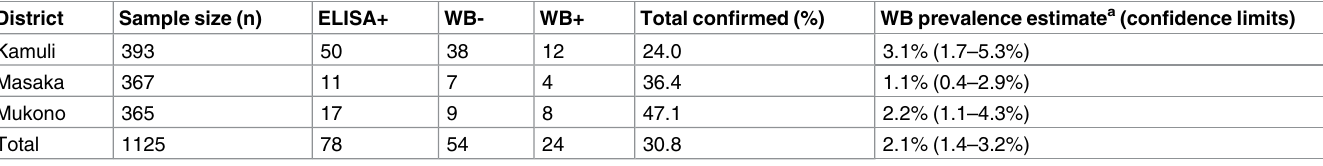
WB: Western Blot a Calculated at p = 0.05 and CI =